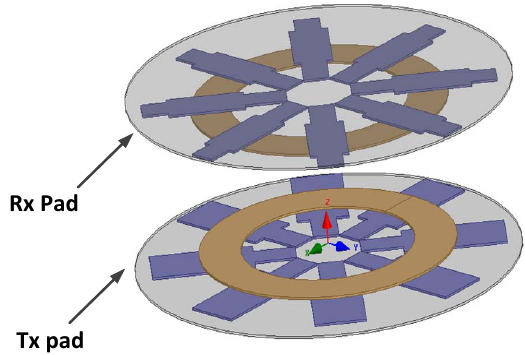
Figure 12. The proposed optimum shaped bars and pad configuration.